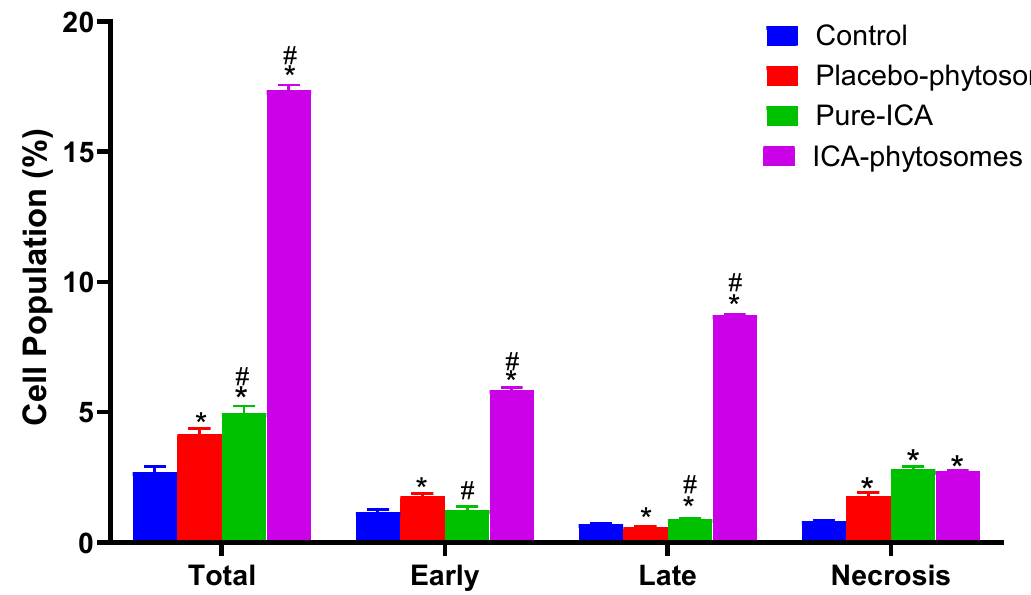
Figure 8. Assessment of OVCAR-3 cell death using flow cytometric analysis after annexin V staining. * Significantly different from control at p < 0.05, # significantly different from placebo-phytosomes at p < 0.05.